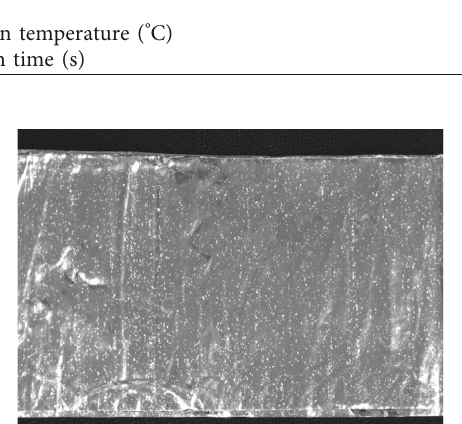
Figure 2: Aluminum foil images after